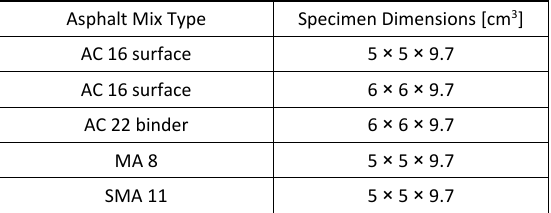
Table 1. Overview of analysed asphalt mixes and specimen